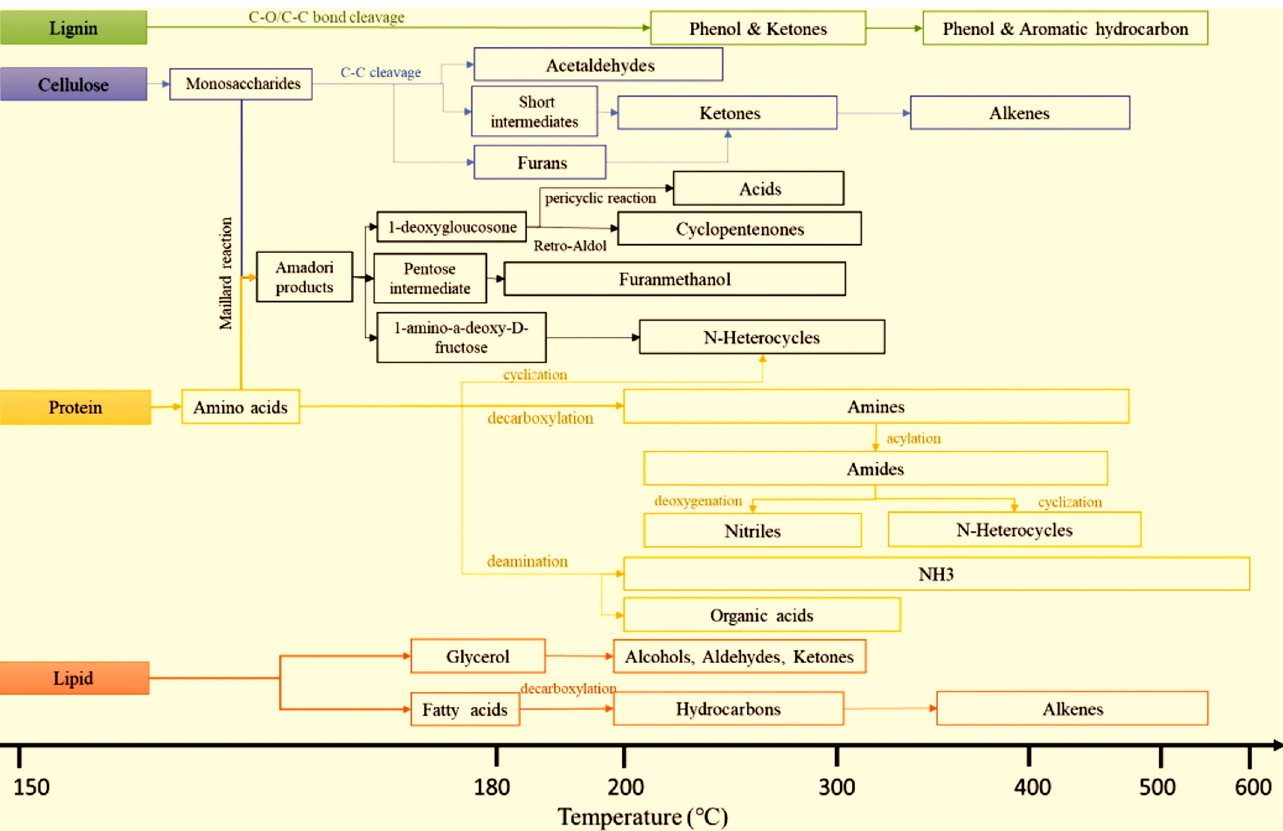
Figure 4. Mechanistic reaction pathways for the pyrolysis of animal manure to bio-oils. Adapted from He et al. [51].